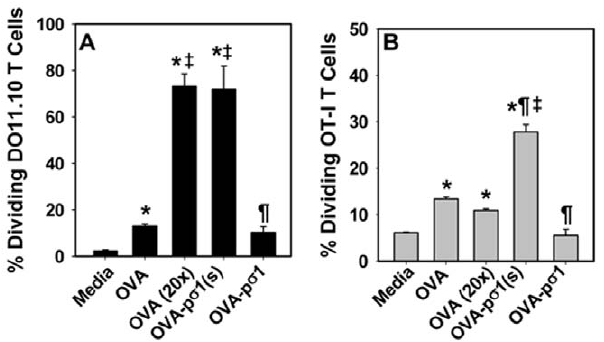
Figure 3. OVA-p s 1(s) is immunostimulatory and can induce transgenic DO11.10 CD4 + and OT-I CD8 + T cells to proliferate. Naive DCs were isolated and pulsed with media, 50 m g/ml, 1.0 mg/ml OVA (20 6 ), 50 m g/ml OVA-p s 1(s), or 50 m g/ml OVA-p s 1, for 24 hrs and co-cultured with carboxy-fluorescein diactetate succinimidyl ester (CFDA)-labeled, purified A. DO11.10 CD4 + or B. OT-I CD8 + T cells for 4 days. Extent of T cell proliferation was measured by flow cytometry. Depicted are the mean 6 SEM of two - three experiments: * P , 0.001 vs. media; " P , 0.001 vs. OVA (20 6 ); { P # 0.002 vs. OVA-p s 1.